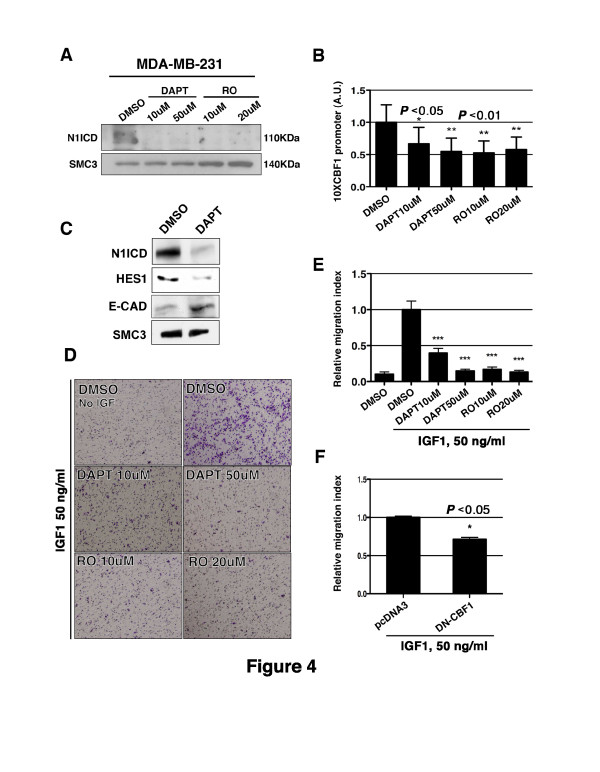
NOTCH signaling inhibition decreases the migratory behavior of MDA-MB-231 cells. (A) Western blot showing Notch one intracellular domain (N1ICD) expression in MDA-MB-231 cells after 48 h of treatment with DAPT or RO4929097 (RO). Equal amounts of protein loading were validated with an anti-SMC3 antibody. (B) Notch activity measured with the 10 × CBF1 reporter. The value for DAPT and RO4929097 treated cells is relative to the activity in cells treated with DMSO. Data are mean ± SEM of quadruplicates in three independent experiments (*P <0.05, **P <0.005 determined by Student's t-test). (C) Representative images of migration towards IGF-1 50 ng/ml of MDA-MB-231 cells with DAPT or RO4929097 or the vehicle DMSO. (D) Migration index obtained in both conditions. Data are mean ± SEM of duplicates in three independent experiments (***P <0.001 determined by Student's t-test). (E) Migration index quantification of MDA-MB-231 cells transfected with an empty vector (pCDNA3) or a dominant negative version of CBF1 (DN-CBF1) towards IGF-1 (50 ng/ml). Data are mean ± SEM of duplicates in three independent experiments (*P <0.05 determined by Student's t-test). CBF1, CSL, Suppressor of Hairless; DAPT, N-(N-(3,5-difluorophenacetyl)-l-alanyl)-S-phenylglycine t-butyl ester; DMSO, dimethyl sulfoxide; MCF-7, Michigan Cancer Foundation-7 breast cancer cell line; MDA-MB-231, Breast cancer cell line derived from metastatic site (pleural effusion); N1ICD, Notch one intracellular domain